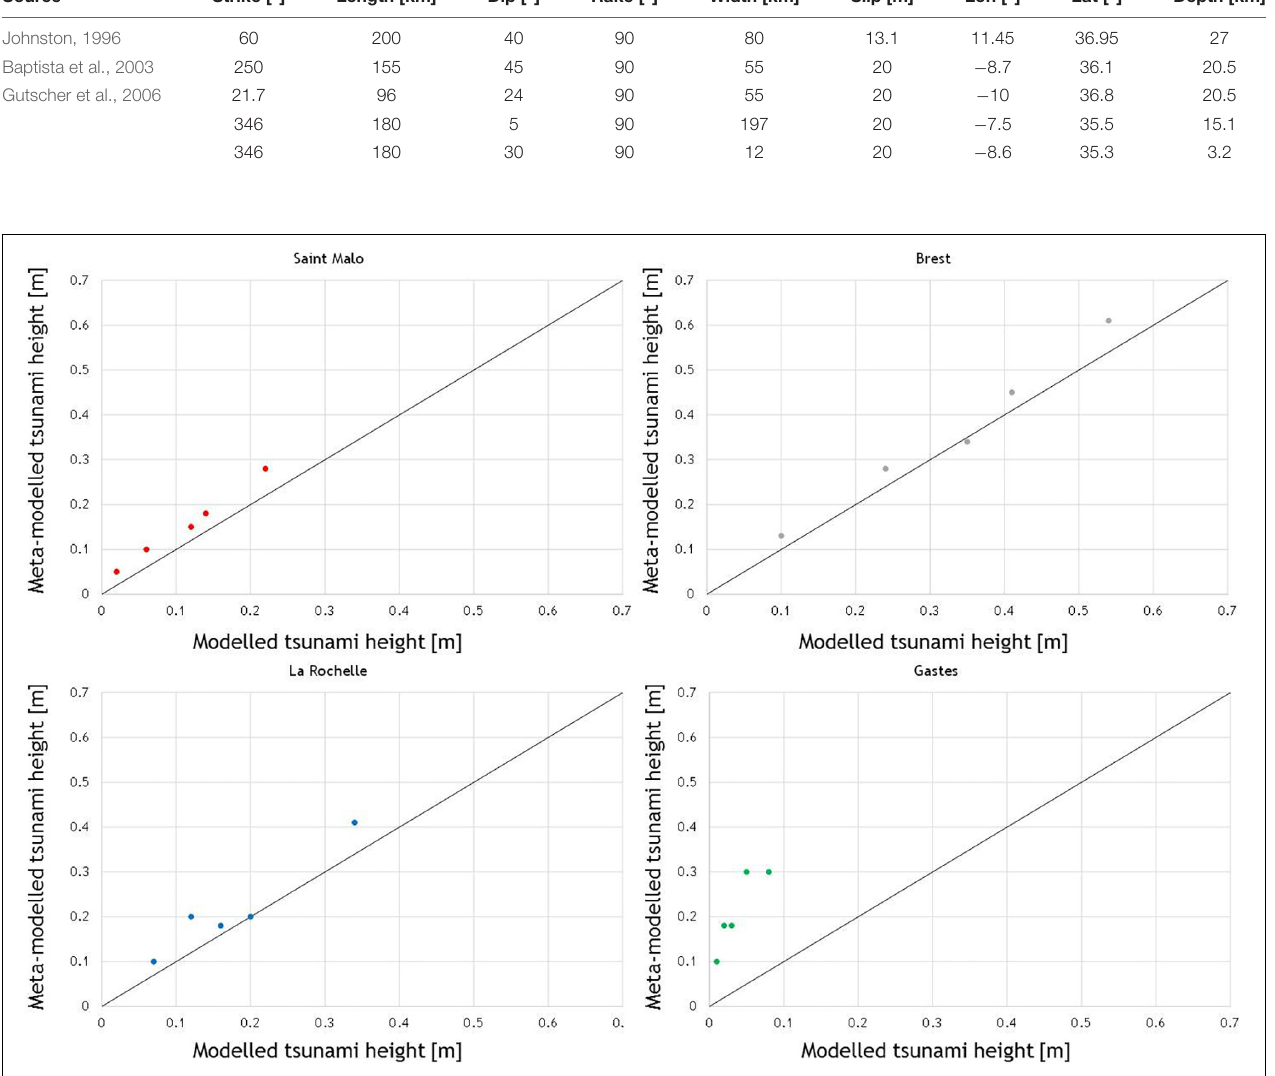
FIGURE 5 | Comparison between the meta-modeled ant the modeled tsunami height issued by the tsunami scenarios reported in Allgeyer et al. (2013). The black line indicates the perfect match (y = y–).